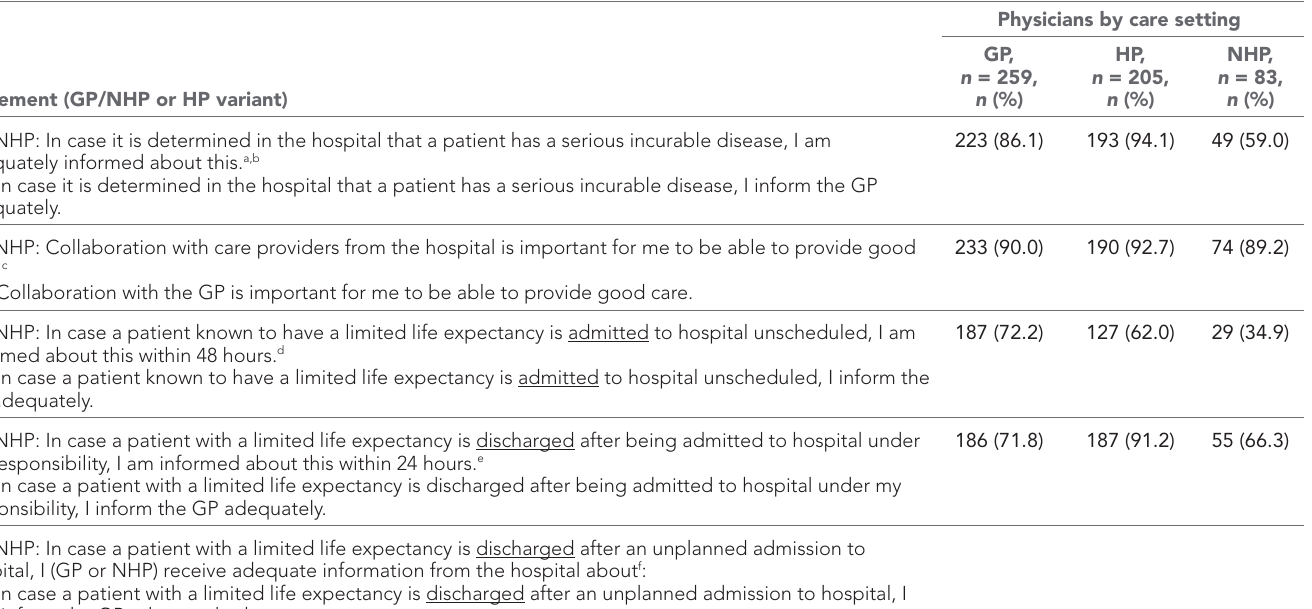
Table 3 Communicating prognosis with physicians working in other care settings, and perceived quality of collaboration Statement (GP/NHP or HP variant)